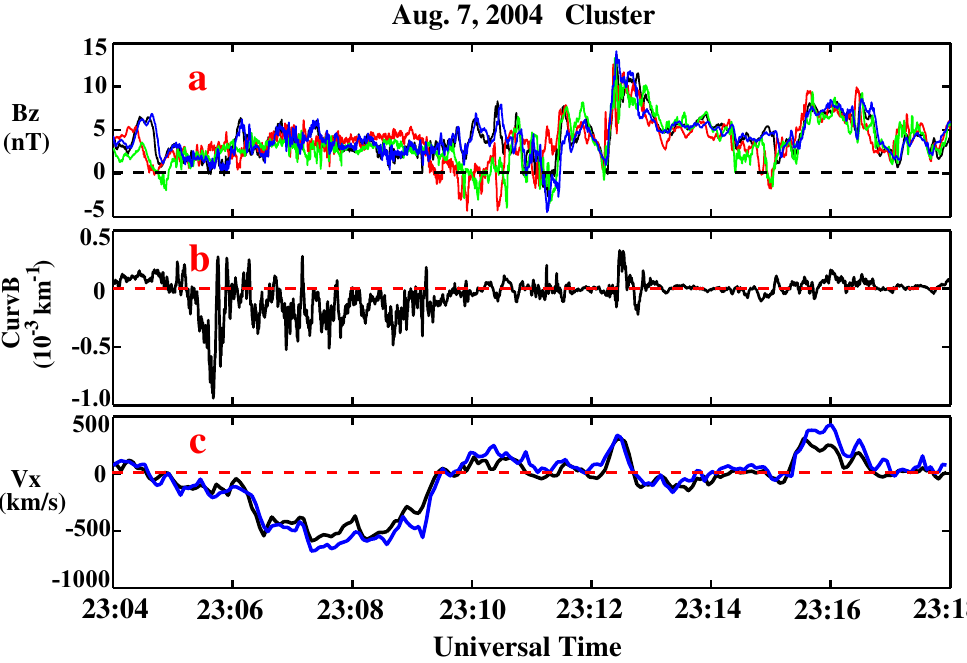
Fig. 3. The magnetic field component of B z , X component of the magnetic field curvature vector and the flow velocity component of V x observed by Cluster in an expanded time scale during the flow